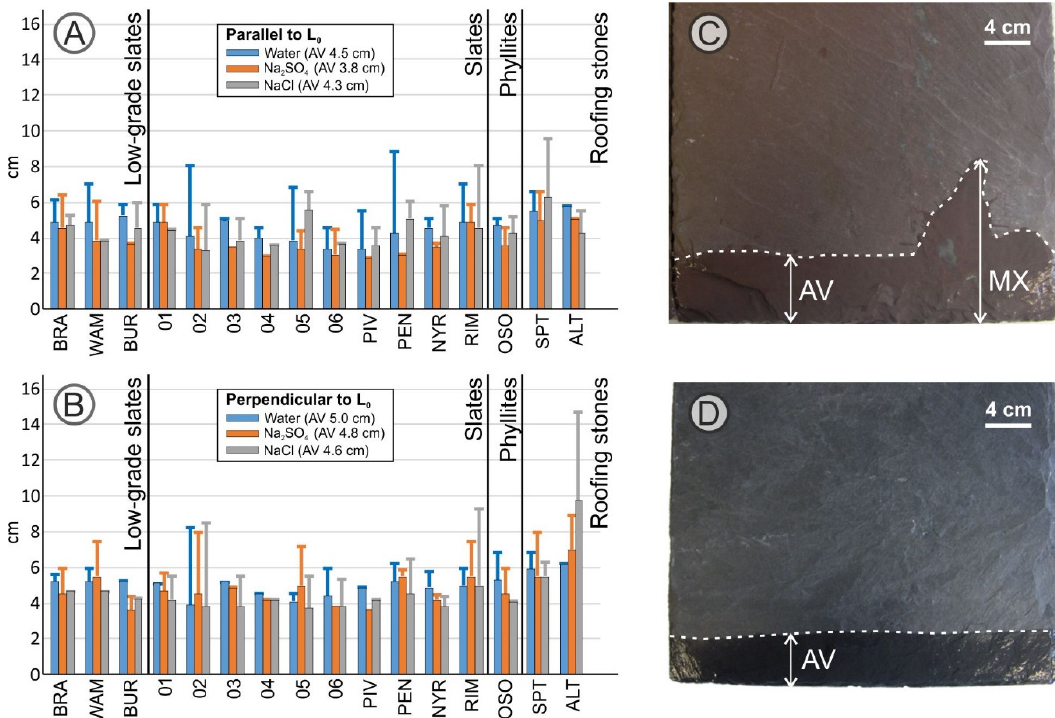
Figure 7. Capillary ascension for distilled water, Na 2 SO 4 solution and NaCl solution. ( A ) and ( B ) show the average values (AV) for each solution are indicated in the legend. The maximum values are indicated by error bars. The samples are sorted by lithotype. ( C ) and ( D ) are examples of water capillary ascension on sample PEN and 01, showing the average and maximum (MX) values marked.